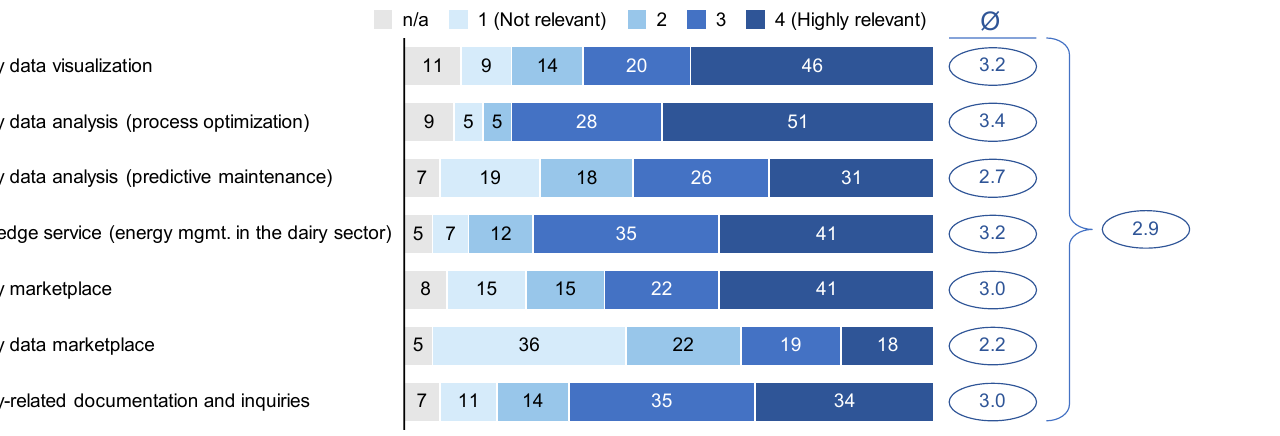
Figure 4. Sample farmers’ responses on relevance of DEMS on a scale from 1 (Not relevant) to 4 (Highly relevant)–translated and simplified .